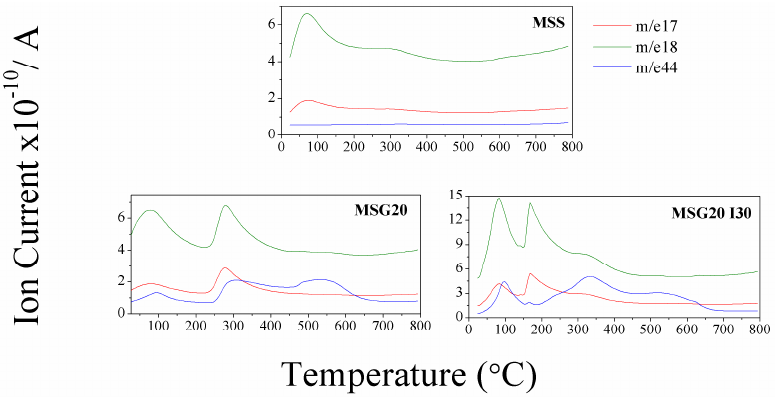
Figure 2. Mass charge ratio distribution measured by TGA.